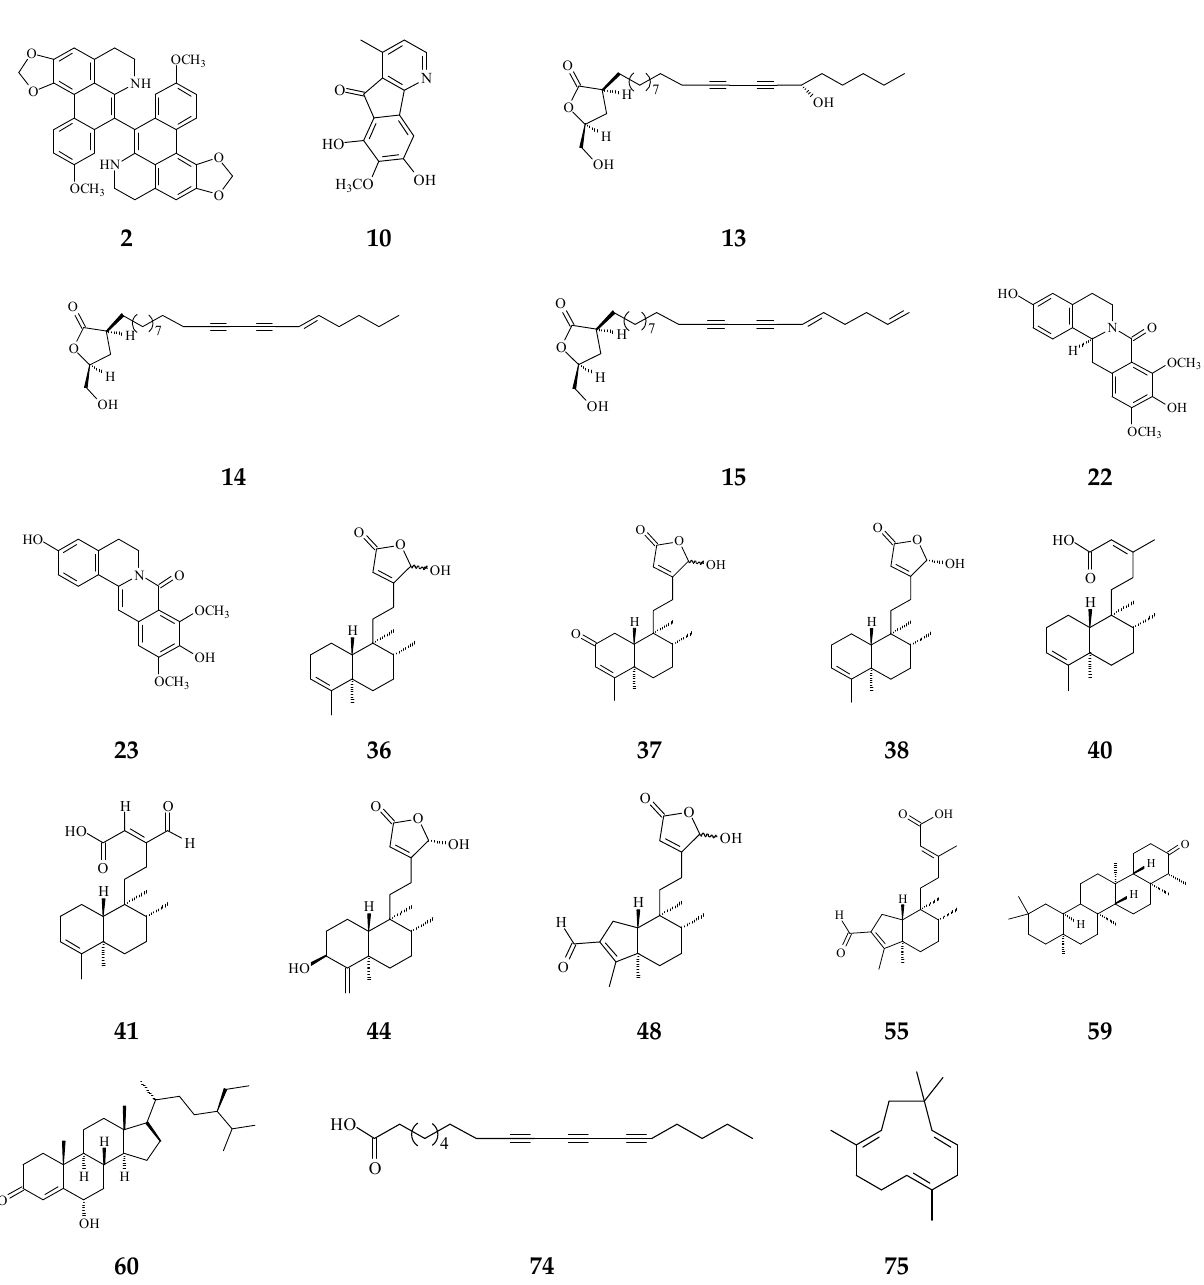
Figure 6. The phytochemical compounds isolated from species of Polyalthia have anti-bacterial (2, 10, 13–15, 22, 23, 36–38, 40, 41, 44, 48, 55, 59, 60, 74, and 75) and anti-fungal (36 and 41) activities. The phytochemical compounds of clerodane diterpenoids 36-38, 16-oxocleroda-3,13 E - dien-15-oic acid (41), 3 β ,16 α -dihydroxycleroda-4(18),13(14) Z -dien-15,16-olide (44), (4 → 2)- abeo-16(R&S)-2,13Z-clerodadien-15,16-olide-3-al (48), solidagonal acid (55), friedelin (59), and stigmast-4-ene-6 α -ol-3-one (60) also display anti-bacterial activity against both Gram- positive and Gram-negative bacteria (Table 1). The tertiary chemoprevention of cancer is aimed to prevent cancer recurrence or second tumor/cancer formation in those who have already suffered from curative treatment [2]. Gram-positive and